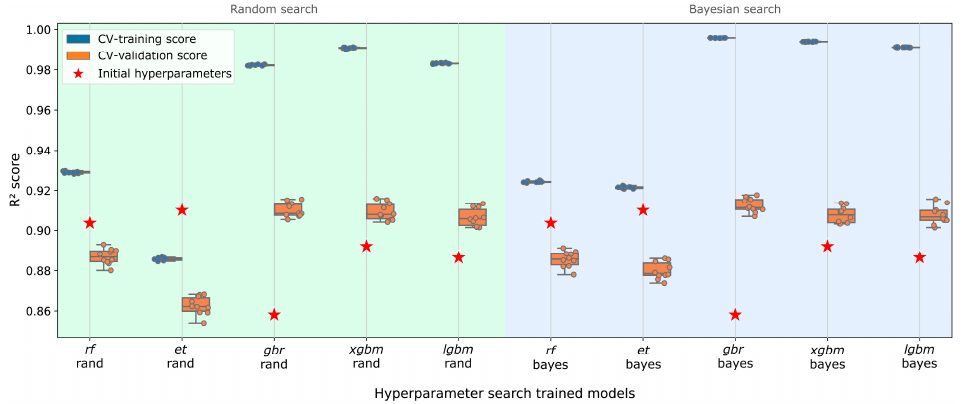
Figure 11. Performance results from the hyperparameter adjustment by cross-validation (R² score of CV-training and CV-validation).